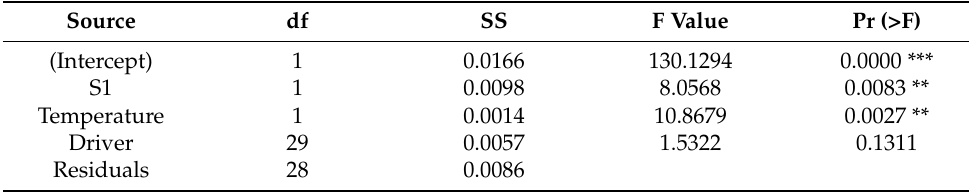
Table 3. ANOVA for initial multiple linear regression.